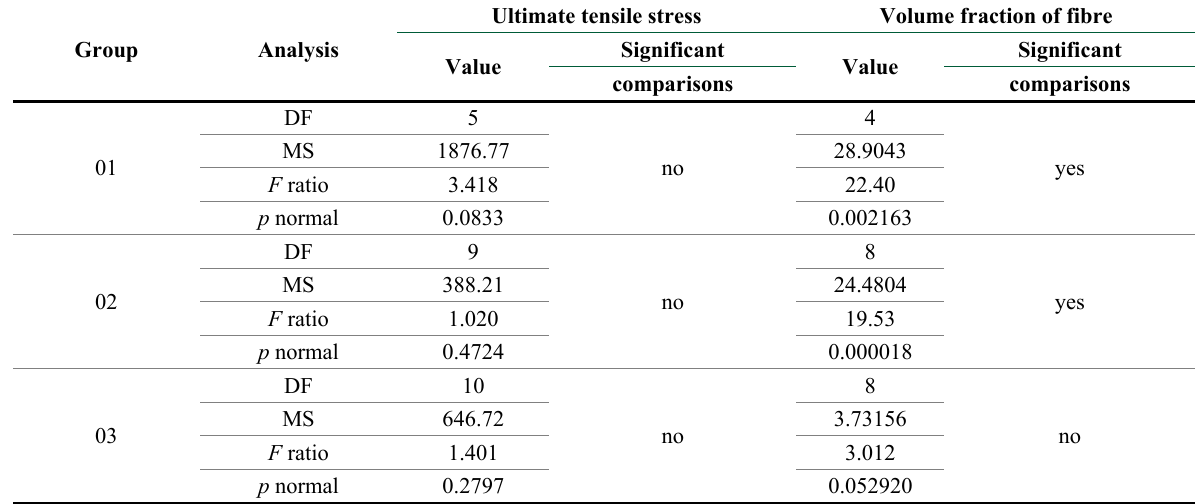
Table 6. ANOVA results for Groups 01, 02 e 03 Group Analysis